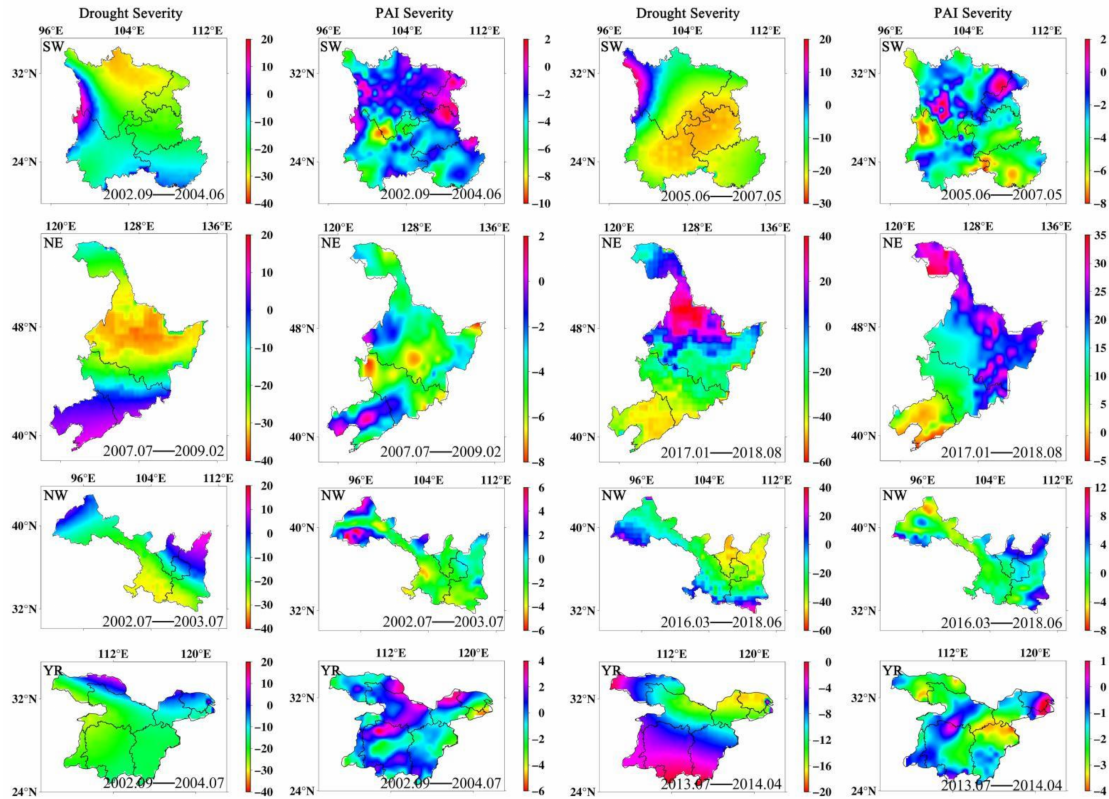
Figure 9. Spatial distribution plot of drought severity and PAI severity of drought events in four study